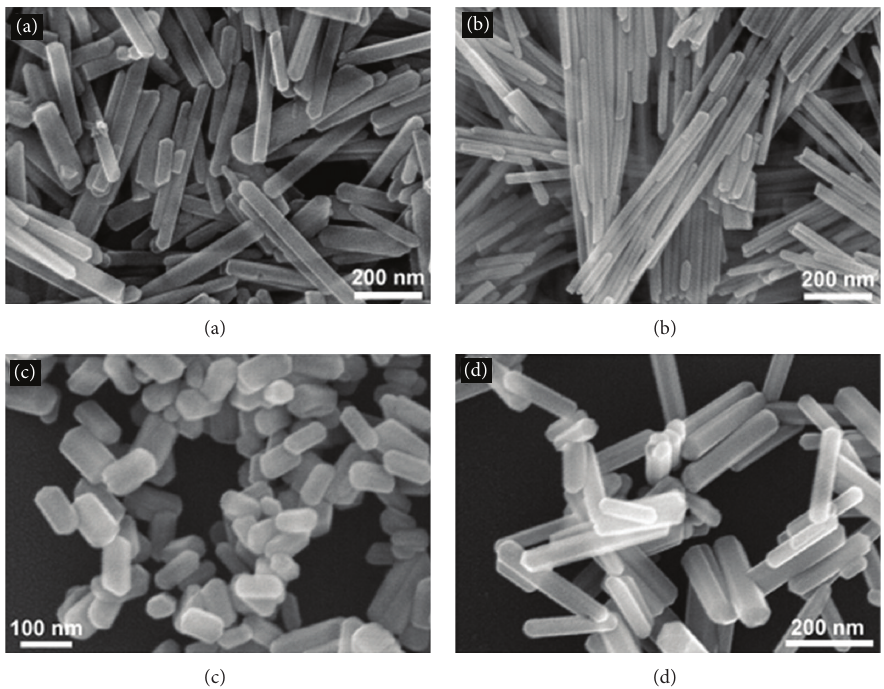
Figure 3: The SEM images of the La(OH) 3 samples prepared at (a) pH = 7 and (b) pH = 10 with ammonia as alkaline source and (c) at pH = 9 with pure hydrazine hydrate and (d) a mixture of ammonia and hydrazine hydrate as alkaline sources